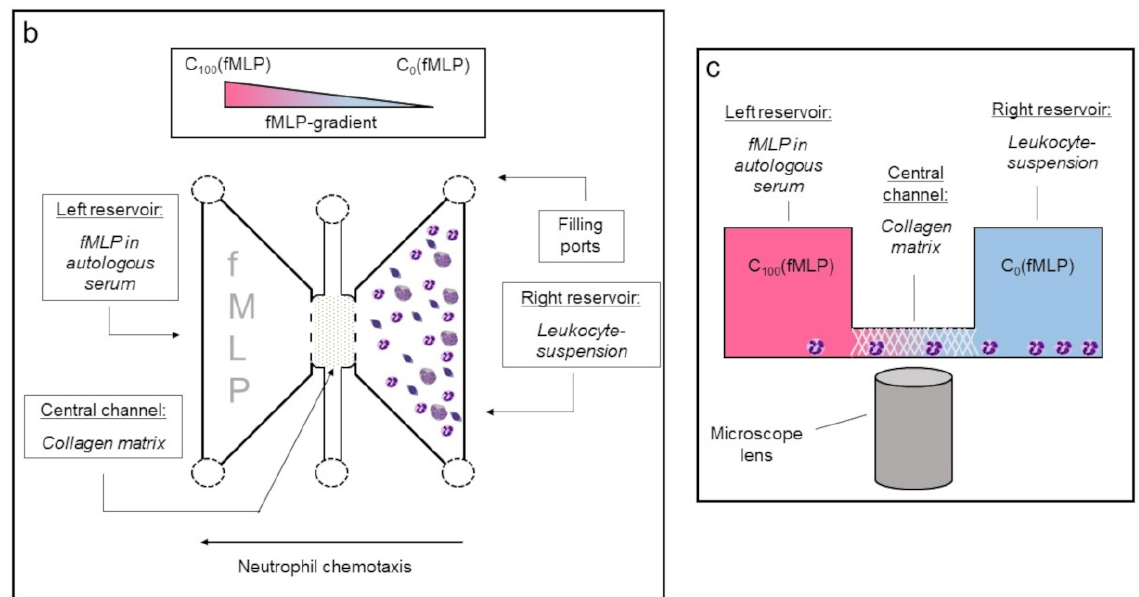
Figure 3. Demonstration of the 3D- µ -Slide migration-chambers used for analysis of neutrophil migration. ( a ) Picture of the slide. The three different chambers are each framed (dashed lines). In each chamber, both reservoirs are colored yellowish for clarification. ( b ) Schematic display of one chamber from top view. The central channel is positioned between both reservoirs in each chamber. ( c ) Cross-sectional view of one chamber. The right reservoir contains the leukocyte-suspension, whereas the left reservoir serves as source for the chemoattractant fMLP. The central channel is filled with a collagen matrix that migrating neutrophils must pass. C 100 (fMLP) indicates that 100% of the chemoattractant is located in the left reservoir immediately after the filling. C 0 (fMLP) indicates that no chemoattractant is located in the right reservoir immediately after the filling.